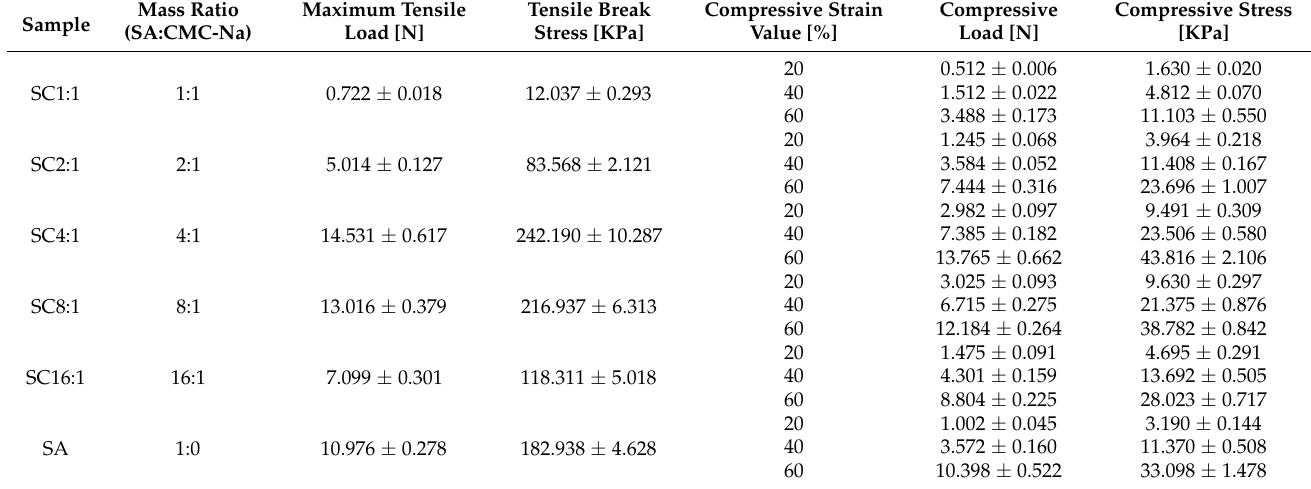
Table 1. The tensile break stress and compression stress of SC blend hydrogels at different compositions. Each value represents the mean ± S.D. ( n =